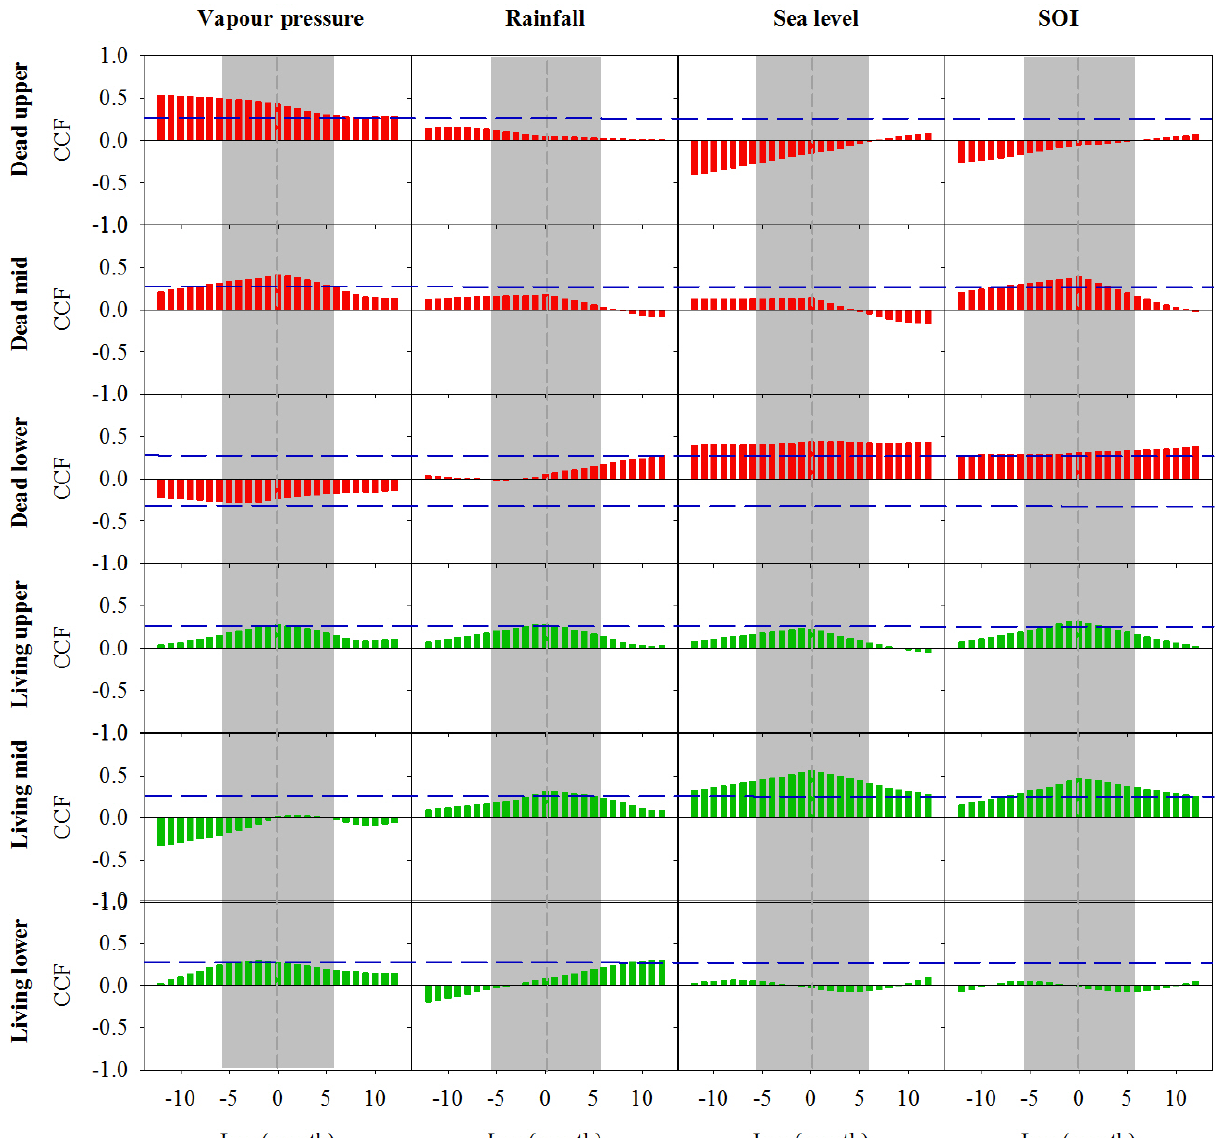
Figure A3. Cross-correlation function (CCF) analysis of the relationship between wood density and climate data over time at a 1-month resolution over a 12-month period prior to and following dieback. Wood samples are from the upper, mid and lower intertidal zones of the dead (red) and living (green) mangrove areas. Blue horizontal dashed lines indicate P < 0 . 01 with n = 125. Grey dashed vertical lines at zero lag indicate the dieback